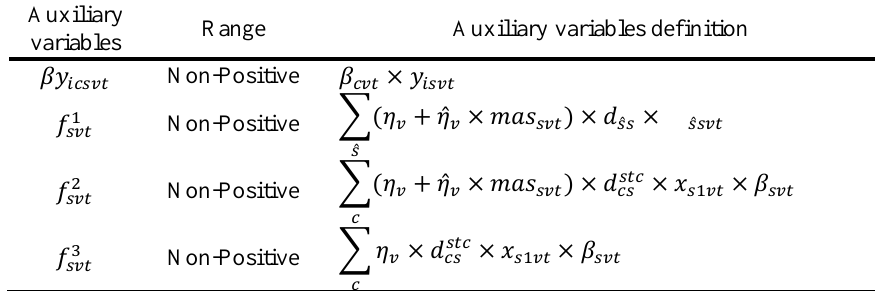
Table 5. Variables for linearization and their